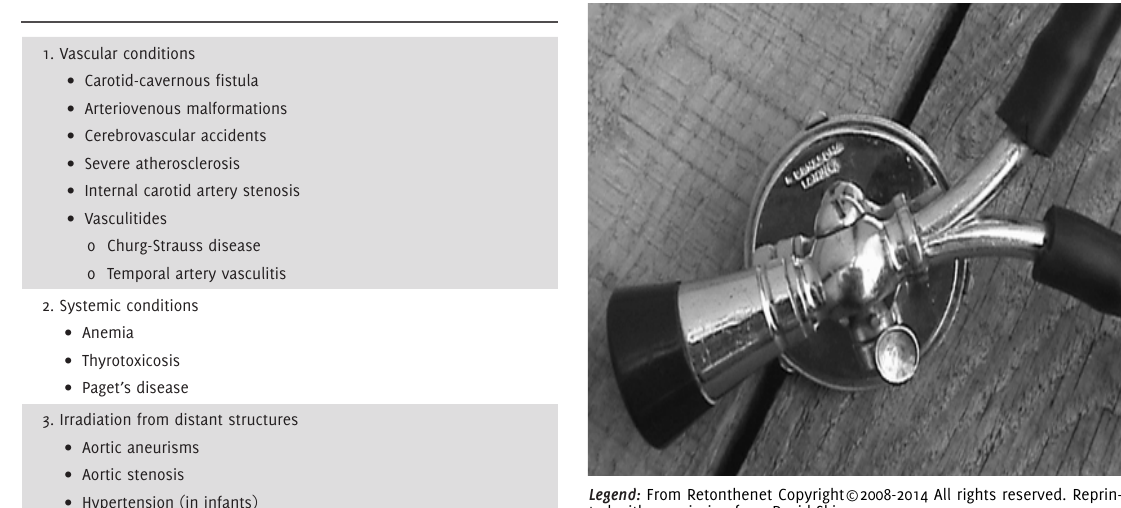
Table 1. Differential Diagnosis of Ocular